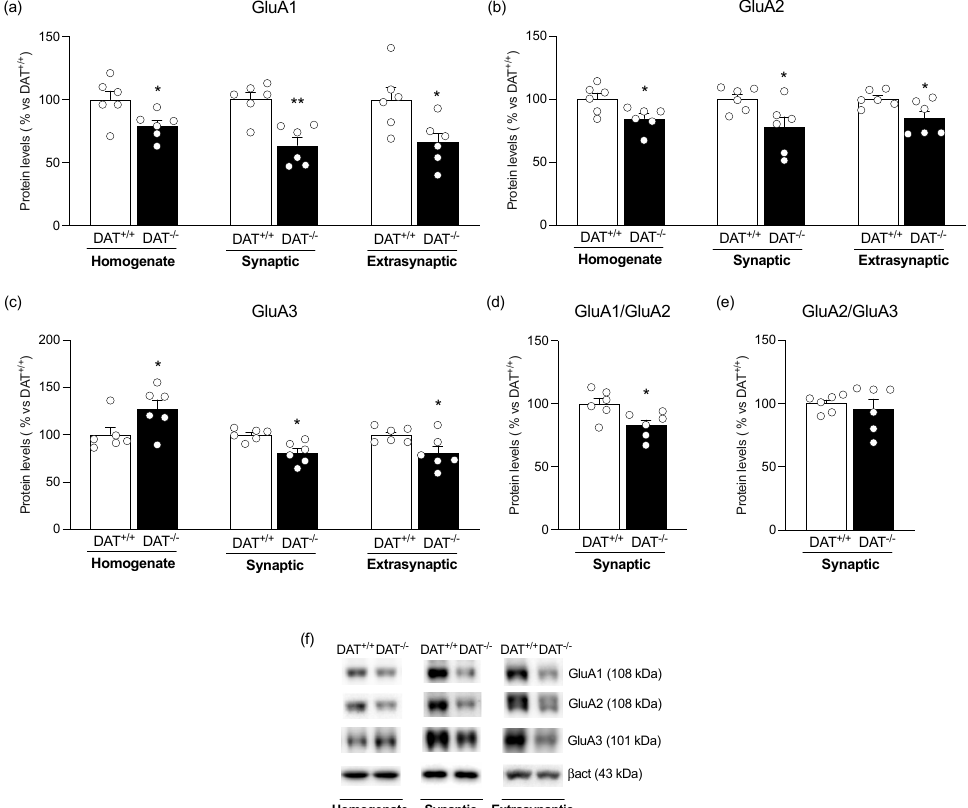
Figure 2b: − 15% vs. DAT +/+ , t = 2.582, p = 0.0273), whereas GluA3 levels were increased (Figure 2c: +27% vs. DAT +/+ , t = 2.261, p = 0.0473). Analysis of AMPA receptor subunits in the subcellular fractions revealed an overall significant reduction in GluA1 (Figure 2a: PSD: − 36% vs. DAT +/+ , t = 4.267, p = 0.0016; Extra-syn: − 34% vs. DAT +/+ , t = 2.720, p = 0.0216), GluA2 (Figure 2b: PSD: − 22% vs. DAT +/+ , t = 2.431, p = 0.0354; Extra-syn: − 15% vs. DAT +/+ , t = 2.465, p = 0.0334), and GluA3 (Figure 2c: PSD: − 19% vs. DAT +/+ , t = 3.616, p = 0.0047; Extra-syn: − 19% vs. DAT +/+ , t = 2.395, p = 0.0376) subunits in both synaptic and extra-synaptic fractions.